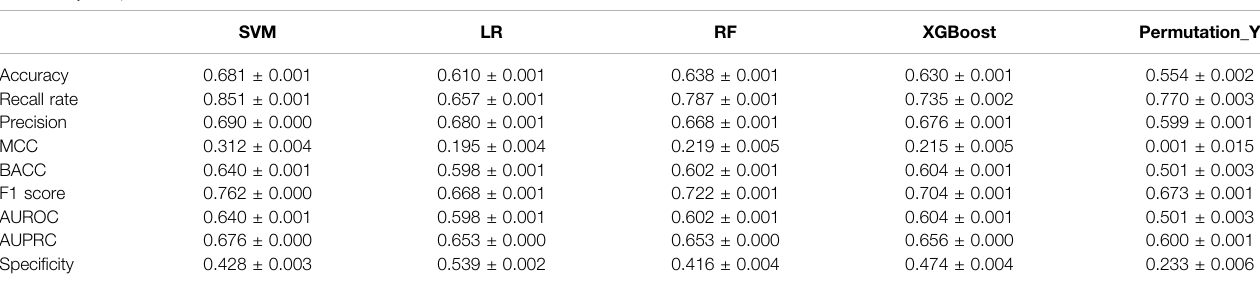
TABLE 2 | The prediction results of SVM, LR, RF, XGBoost and Permutation_Y*. SVM LR RF XGBoost Permutation_Y Accuracy 0.681 ± 0.001